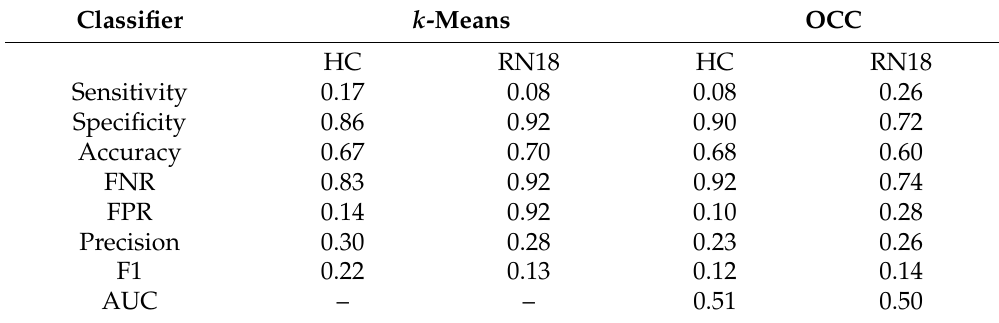
Table 6. Results with OCC and